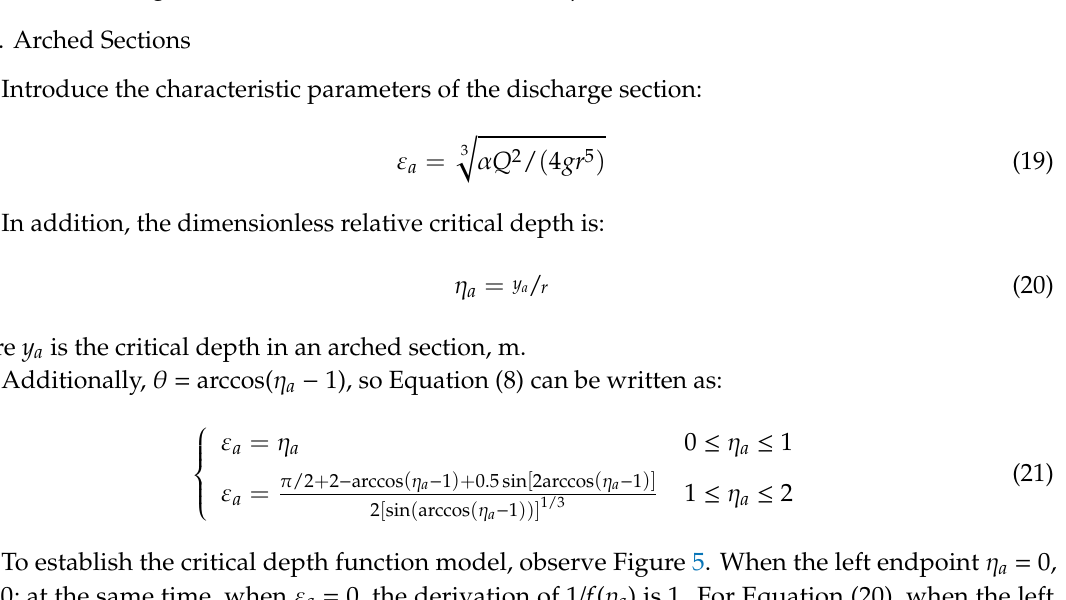
Figure 4. The relation curve between ε and η c functions of circular section.